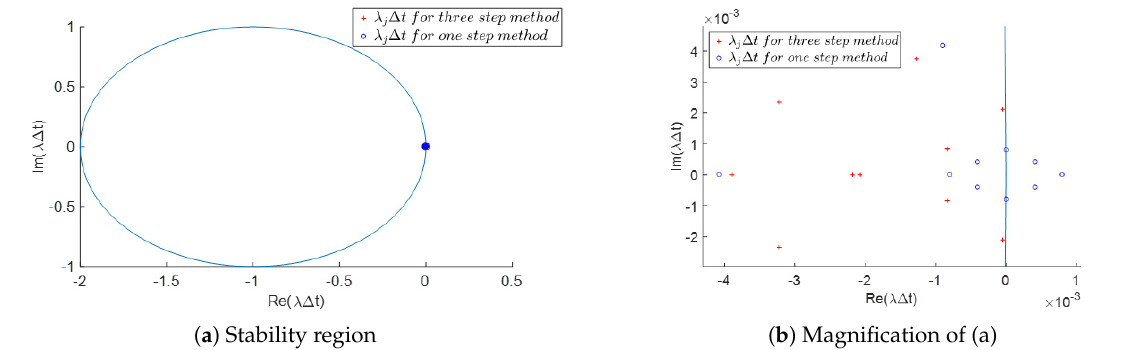
Figure 6. Stability region of Example 3 with the position of λ j ∆ t for M = 8, K = 1 and ∆ t = 0.006. ( b ) is obtained from the magnification of ( a